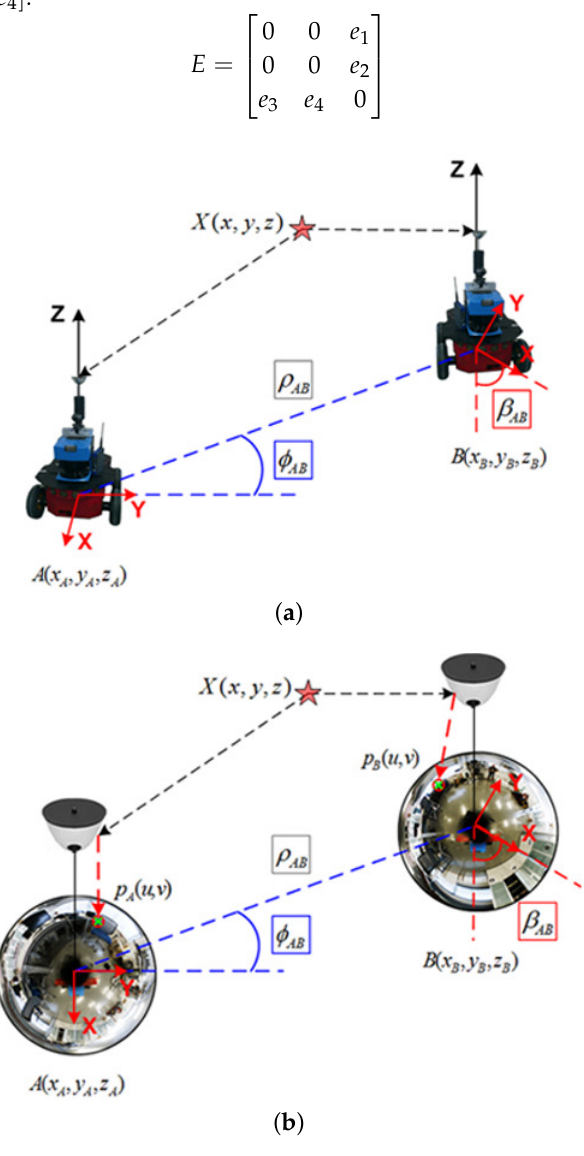
Figure 4. Motion recovery between poses A and B : ( a ) robot reference system; ( b ) analogous relation in the camera reference system. A 3D point, X ( x , y , z ) is indicated with its image projection (in pixels) on both camera frames, as p A ( u , v ) and p B ( u , v ) ,